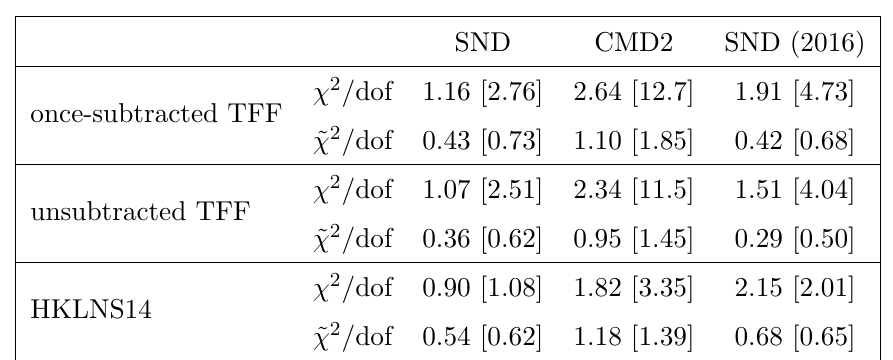
Table 2. Reduced (cid:31) 2 and ~ (cid:31) 2 for the e + e (cid:0) (cid:25) 0 (cid:13) cross section determined from the once-subtracted ! and the unsubtracted TFFs and from [62] (HKLNS14), compared to SND [167, 168], CMD2 [169], and SND (2016) [170] below 1 GeV [below 1 : 1